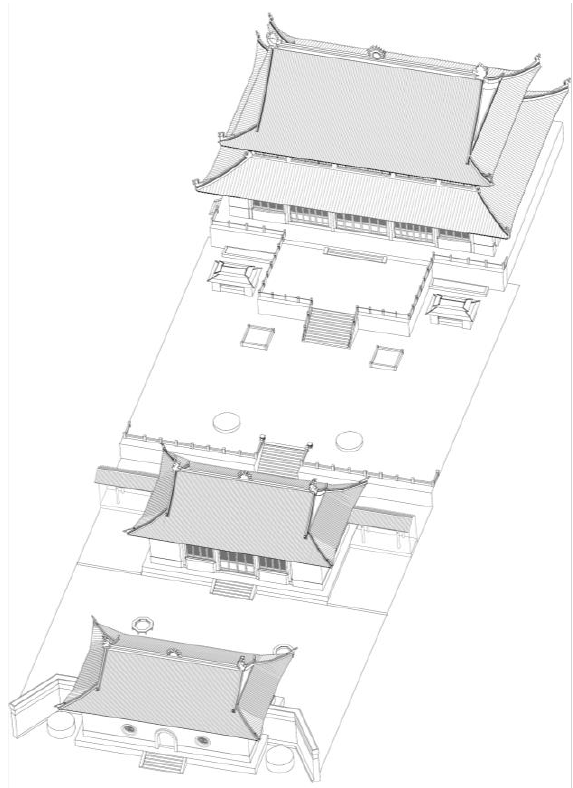
Figure 6. Axonometric aerial view of the Three Temples.